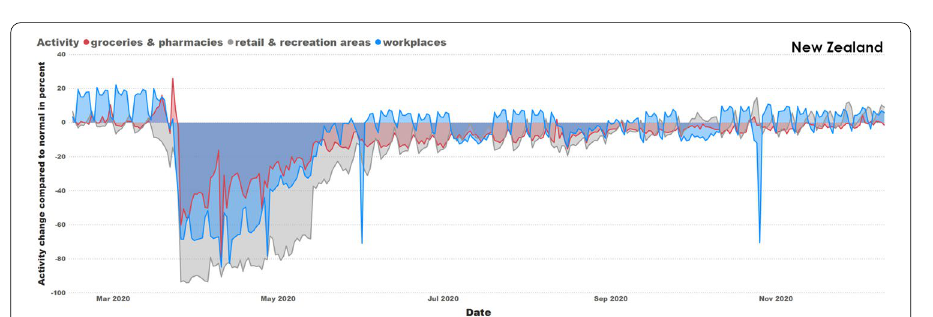
Fig. 22 Single intense lockdown